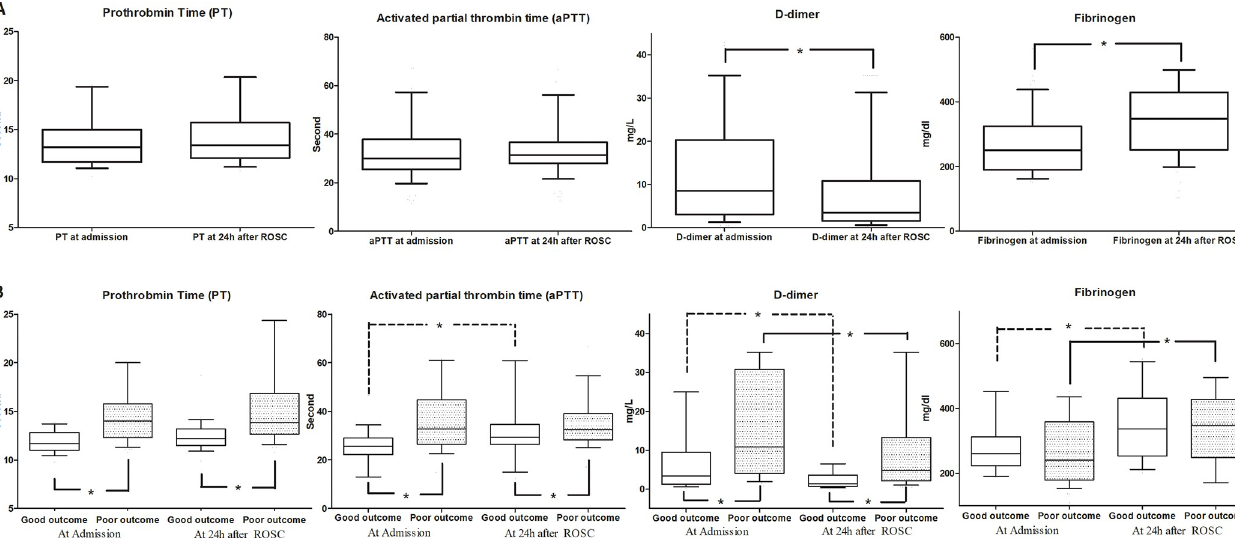
Fig 1. Coagulation-related factors and outcome groups of the study patients. The medians with interquartile ranges (box) and 10 th -90 th percentiles (whiskers) are presented. A represents coagulation-related factors between admission and 24 hours after ROSC. B represents coagulation-related factors according to neurological outcomes between admission and 24 hours after ROSC. (Differences between the groups are statistically significant at the p < 0.05 level).